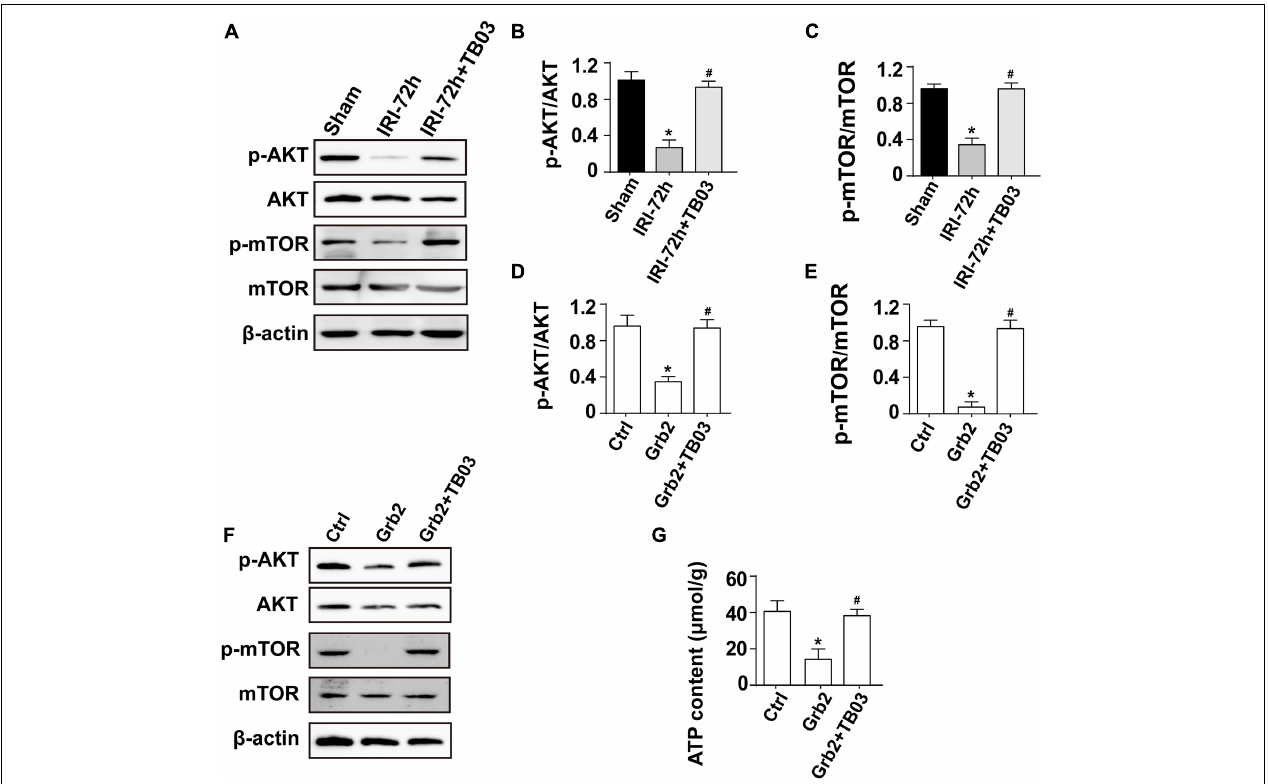
FIGURE 5 | Grb2 activates the Akt/mTOR signaling pathway in cardiomyocytes. (A–C) Heart tissues from mice and the protein expression of p-Akt and p-mTOR were measured through western blots. (D–F) Cardiomyocytes were treated with exogenous Grb2 and its inhibitor TB03. Then, the protein expression of p-Akt and p-mTOR were measured through western blots. (G) The levels of intracellular ATP production were measured through Enhanced ATP Assay Kit. * p < 0.05 vs. sham group, # p < 0.05 vs. IRI-72h